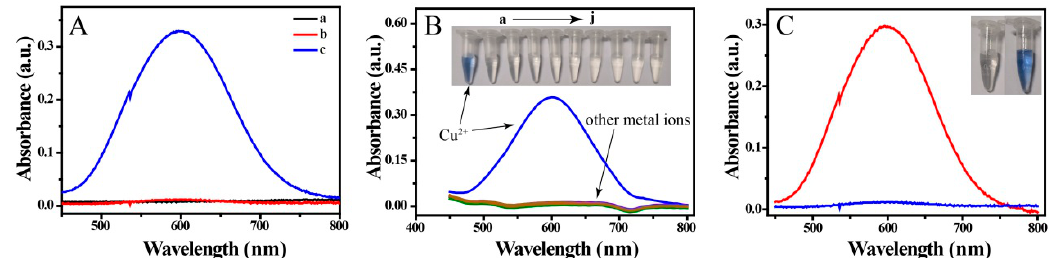
Figure 2. ( A ) Absorbance spectra of (a) Cu 2+ and (b) bis(cyclohexanone)oxaldihydrazone (BCO) in solution of sodium citrate and triethanolamine and (c) mixture of Cu 2+ and BCO in the solution; ( B ) absorbance spectra and photographs of BCO mixed with various metal ions, namely Cu 2+ , K + , Na + , Ag + , Mg 2+ , Ca 2+ , Cd 2+ , Co 2+ , Al 3+ and Fe 3+ (20 μ M); and ( C ) absorbance spectra and photographs of sensing solution in absence (blue curve) and presence of MC-LR (15 nM, red curve).